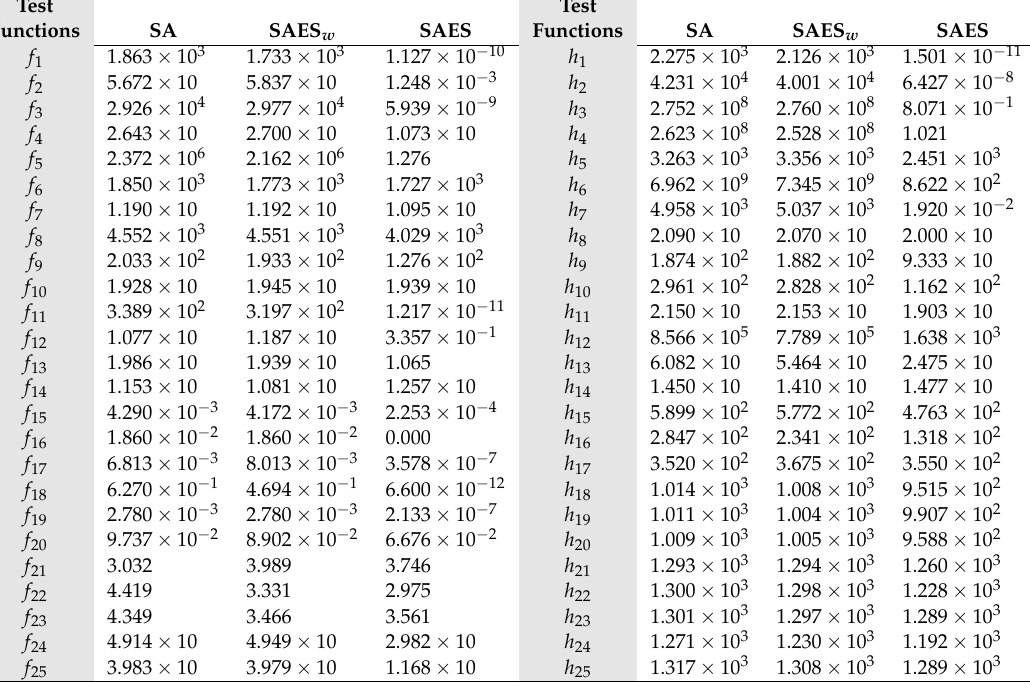
Table 4. Average errors of the results in Tables 2 and 3 using the classical and hard test